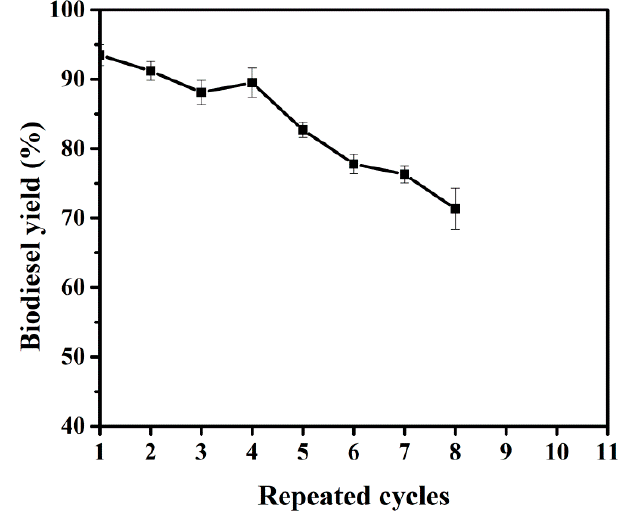
Figure 8. Reuse the catalyzed BCL-ZIF-8 for biodiesel production. Table 1. Comparison between the BCL-ZIF-8 with different immobilized lipases for biodiesel production. Enzyme